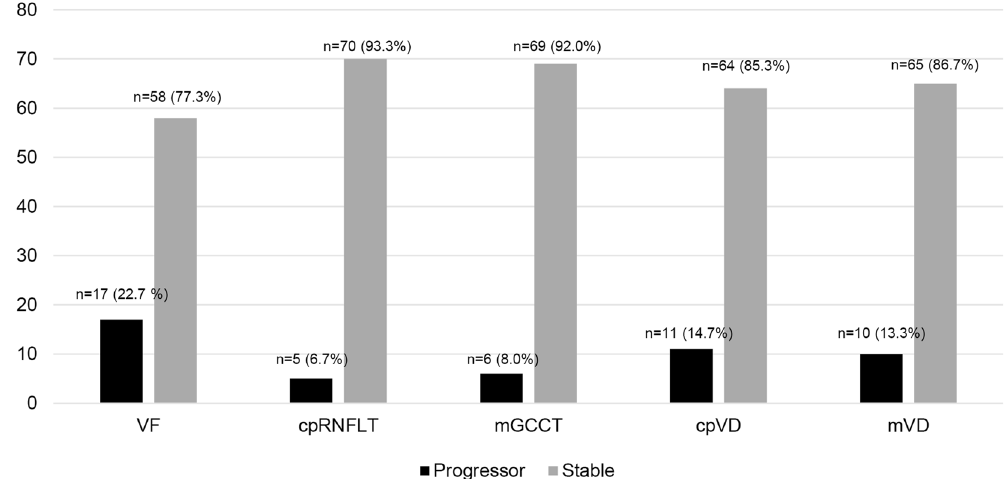
Figure 1. Histogram illustrating the number of eyes with progression (black bars) and stable eyes (gray bars). cpRNFLT circumpapillary retinal nerve fiber layer thickness, cpVD circumpapillary vessel density, GCCT ganglion cell complex thickness, mVD macular vessel density, n number, VF visual field,